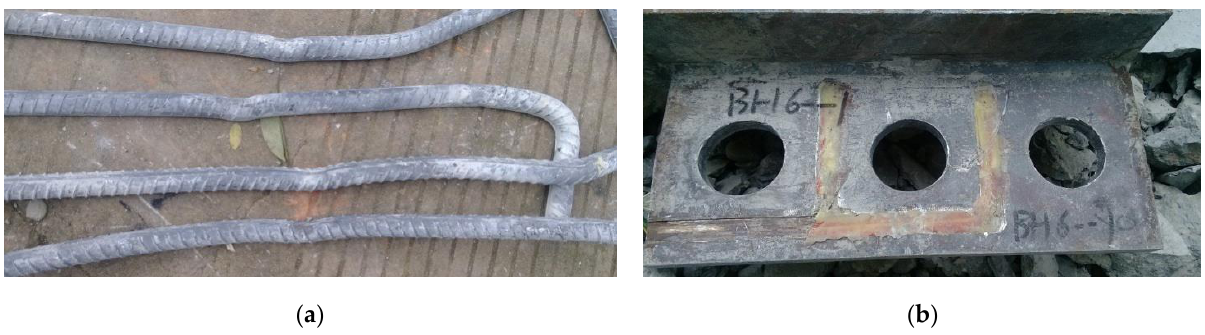
Figure 23. Rib plate and reinforcement of the BH 6-1 specimen after the test: ( a ) Deformation form of reinforcement; ( b ) Deformation form of rib plate.